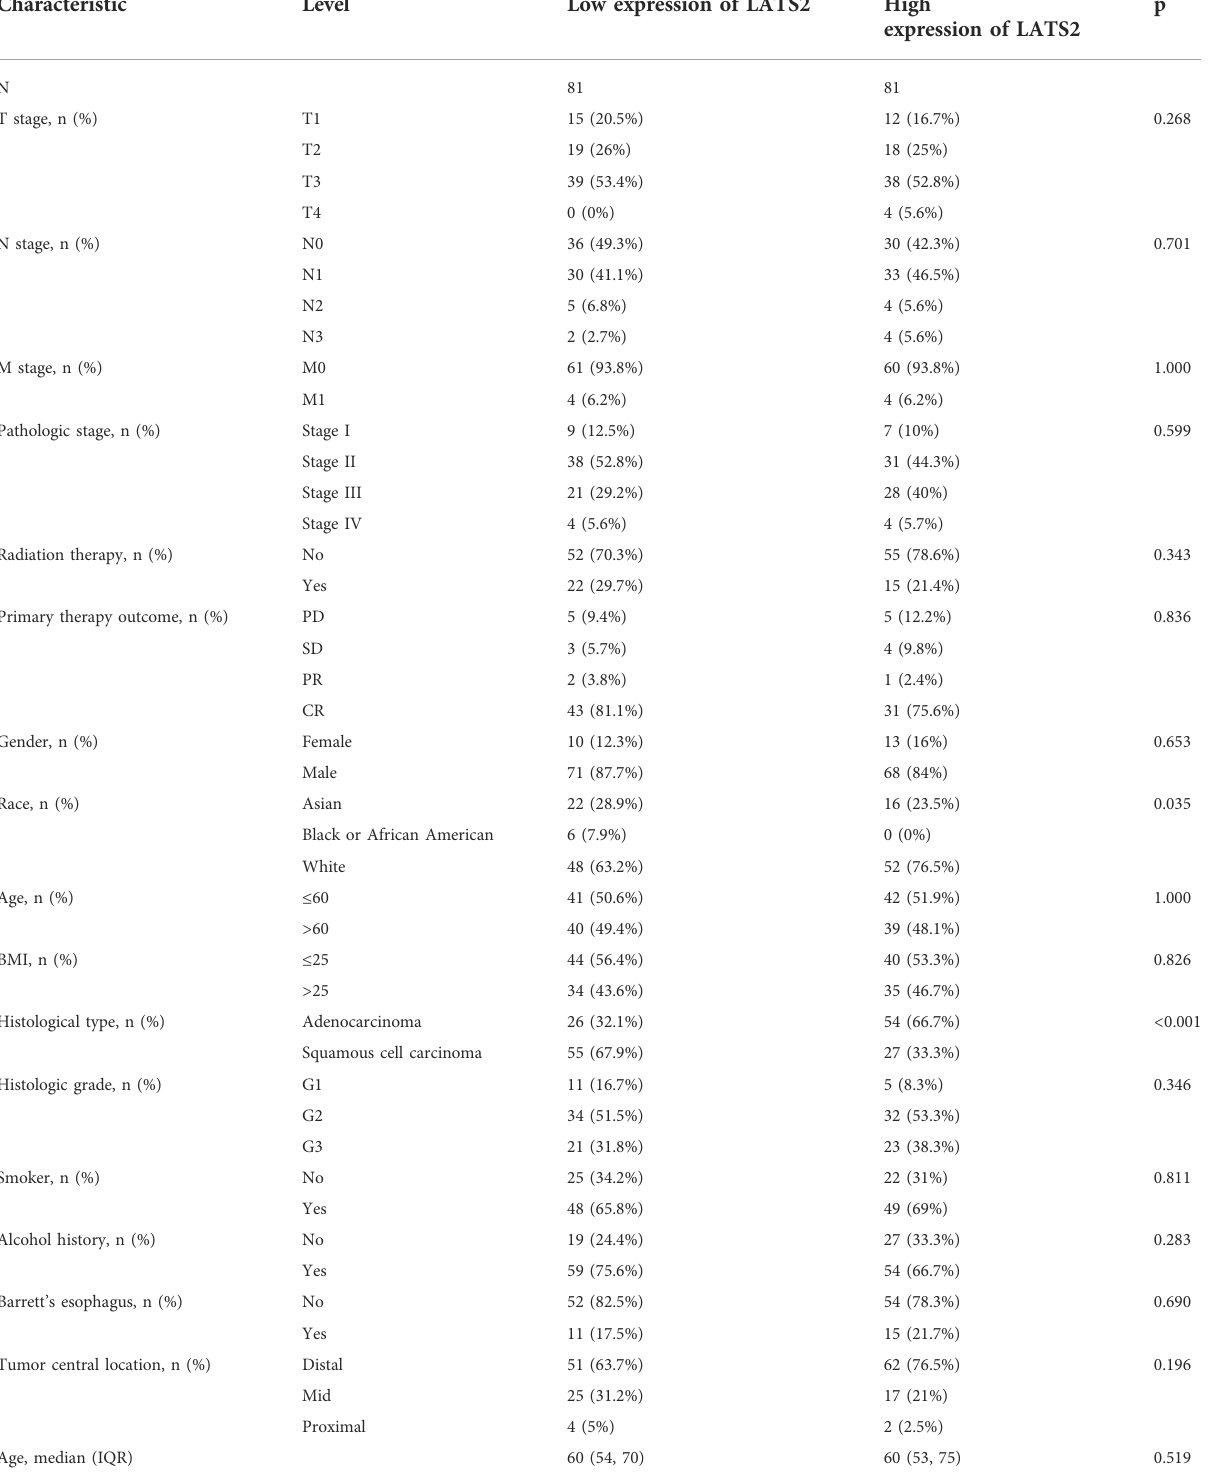
TABLE 1 Relationship between clinical factors and LATS2 expression in